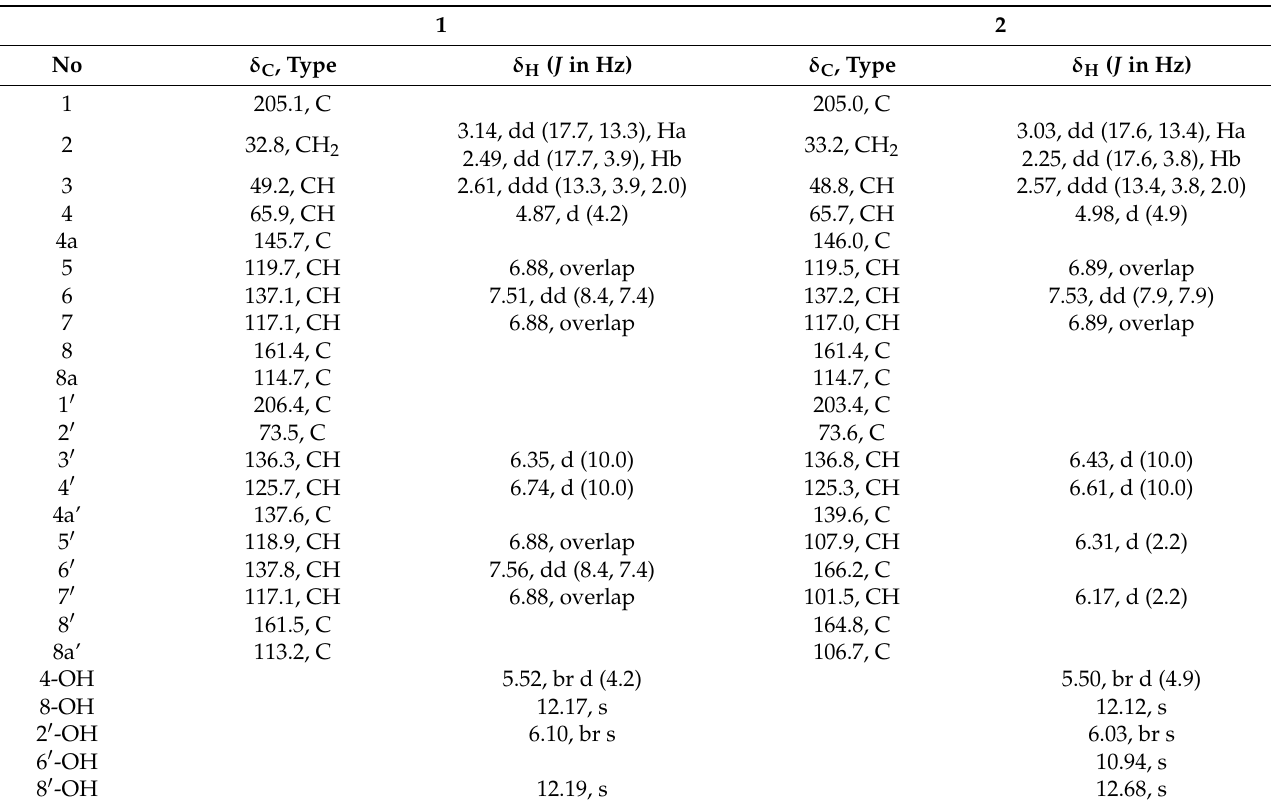
Table 2. The 1 H (600 MHz) and 13 C NMR (150 MHz) Data of Compounds 1 and 2 in DMSO- d 6